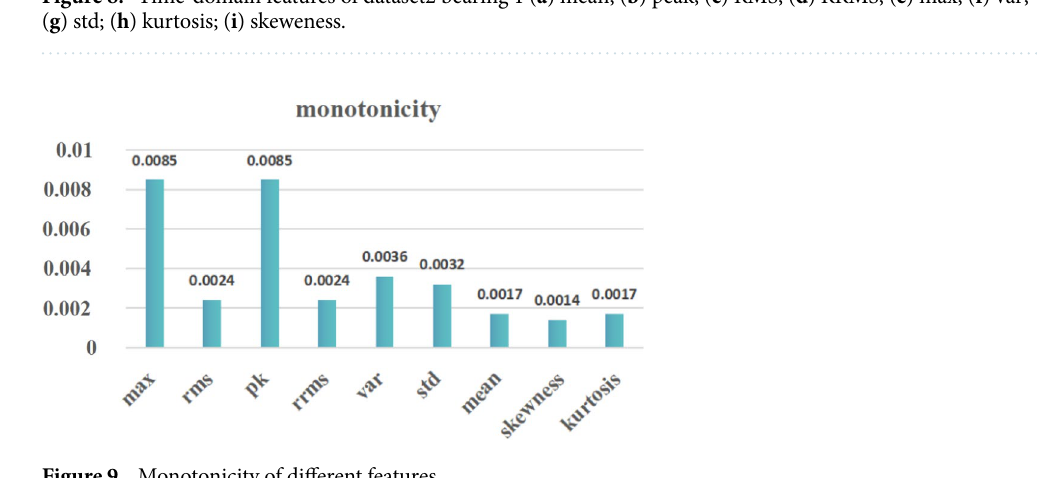
Figure 9. Monotonicity of different